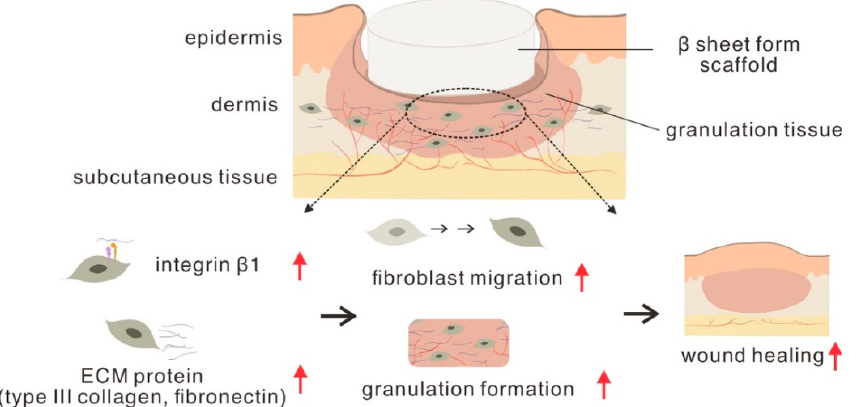
Figure 10. Schematic illustration of the summary in this study.